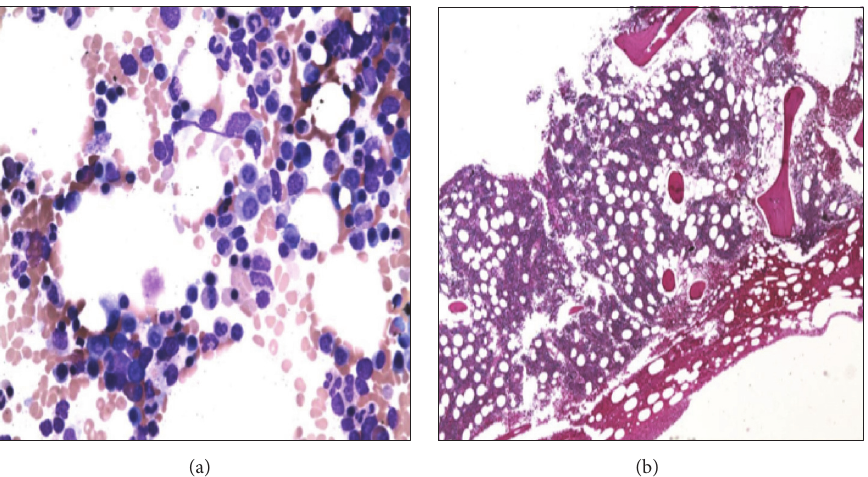
Figure 1: Bone marrow aspirate (a) and biopsy (b) showing scattered interstitial and focally clustered plasma cells and a small bland nonparatrabecular lymphoid aggregate.